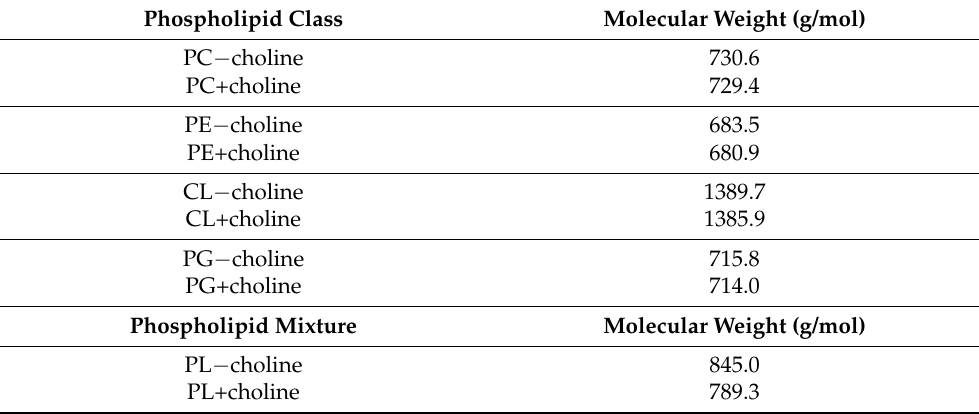
Table 1. Molecular weight of phospholipid classes and their